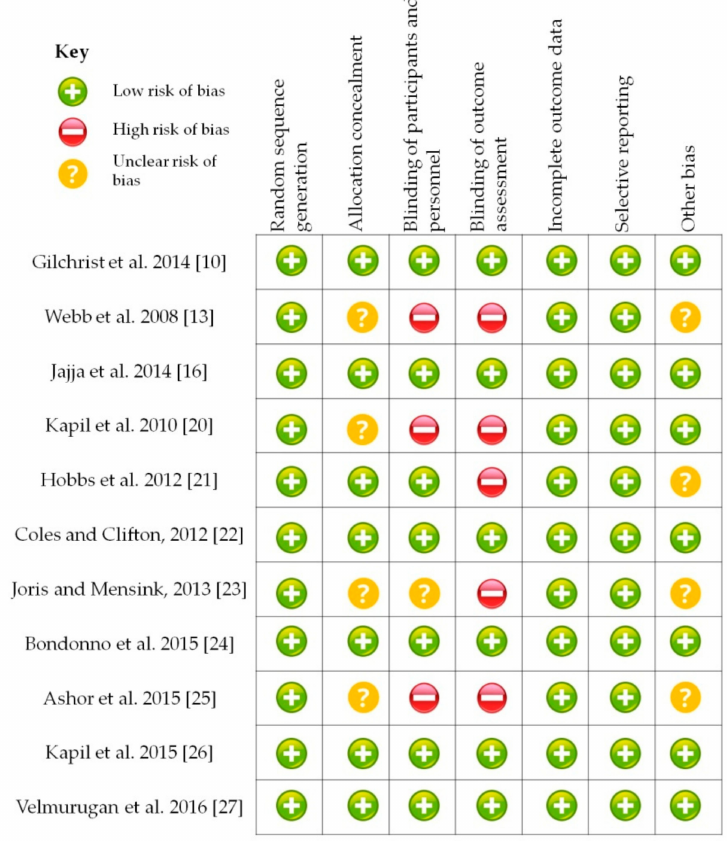
Figure 3. Risk of bias